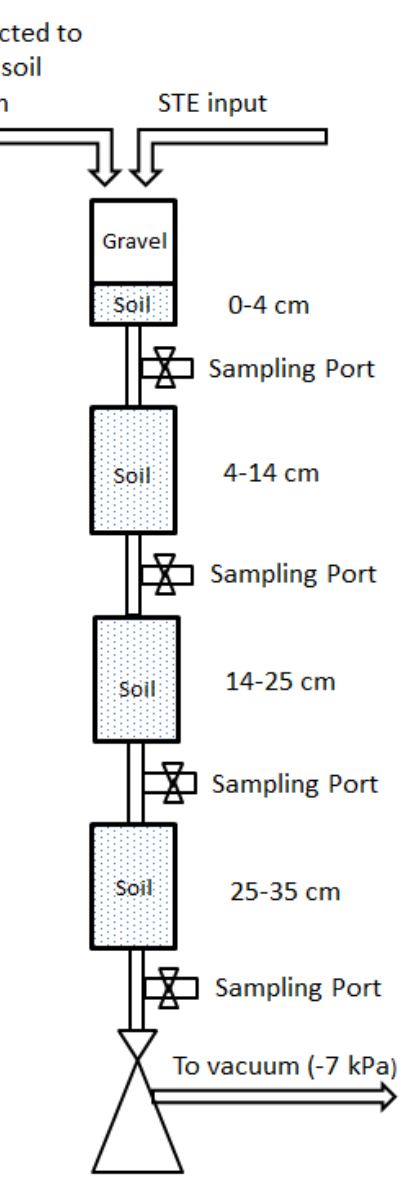
Figure 1. Schematic of experimental setup. Drawing is not to